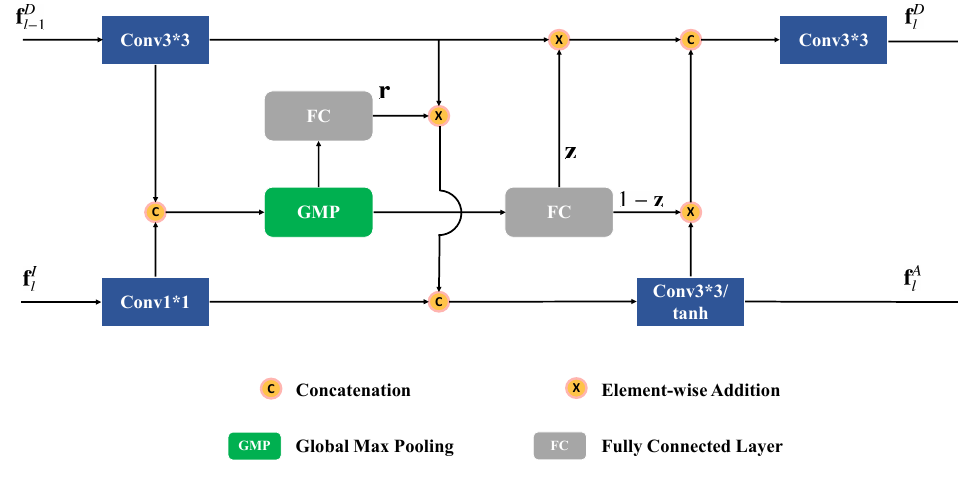
Figure 3. Structure of the ADIM